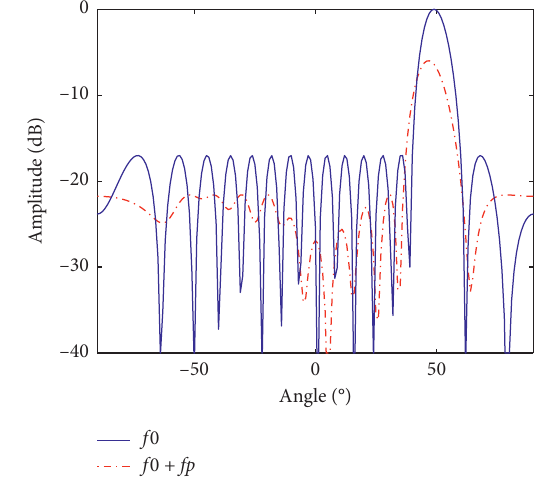
Figure 10: Sum and difference beam under angle scan ( θ